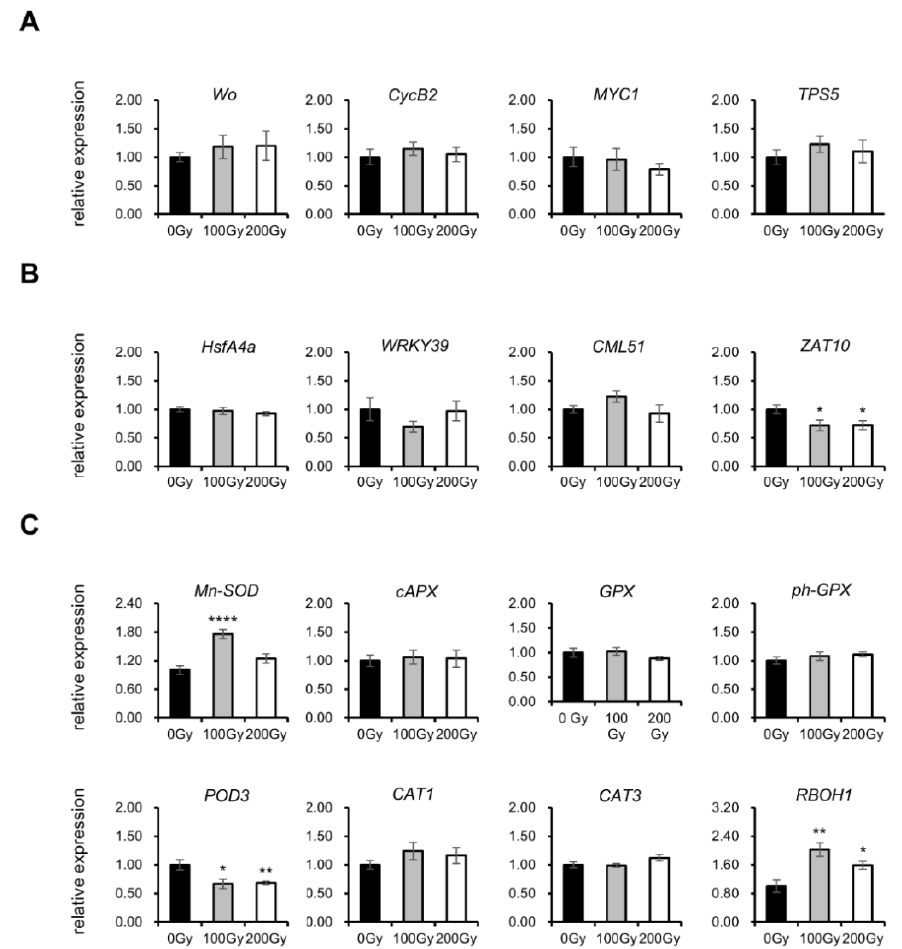
Figure 4. Expression levels of genes involved in trichome development, reactive oxygen species (ROS) signaling, and scavenging in leaves of gamma-irradiated M 2 plants. M 2 seeds harvested from the control (0 Gy) M 1 plants and the M 1 plants irradiated with 100 or 200 Gy of gamma rays were germinated, cultivated for 7 weeks, and assessed. Gene expression levels were analyzed via qRT-PCR, and the values were normalized to the levels in control plants. Data are presented as mean ± SE of six biological replicates. Asterisks represent significant differences between gamma-irradiated and control plants (unpaired t -test: * p < 0.05; ** p < 0.01; **** p < 0.0001). ( A ) Genes involved in trichome development. ( B ) Genes related to ROS signaling. ( C ) Genes involved in ROS scavenging.